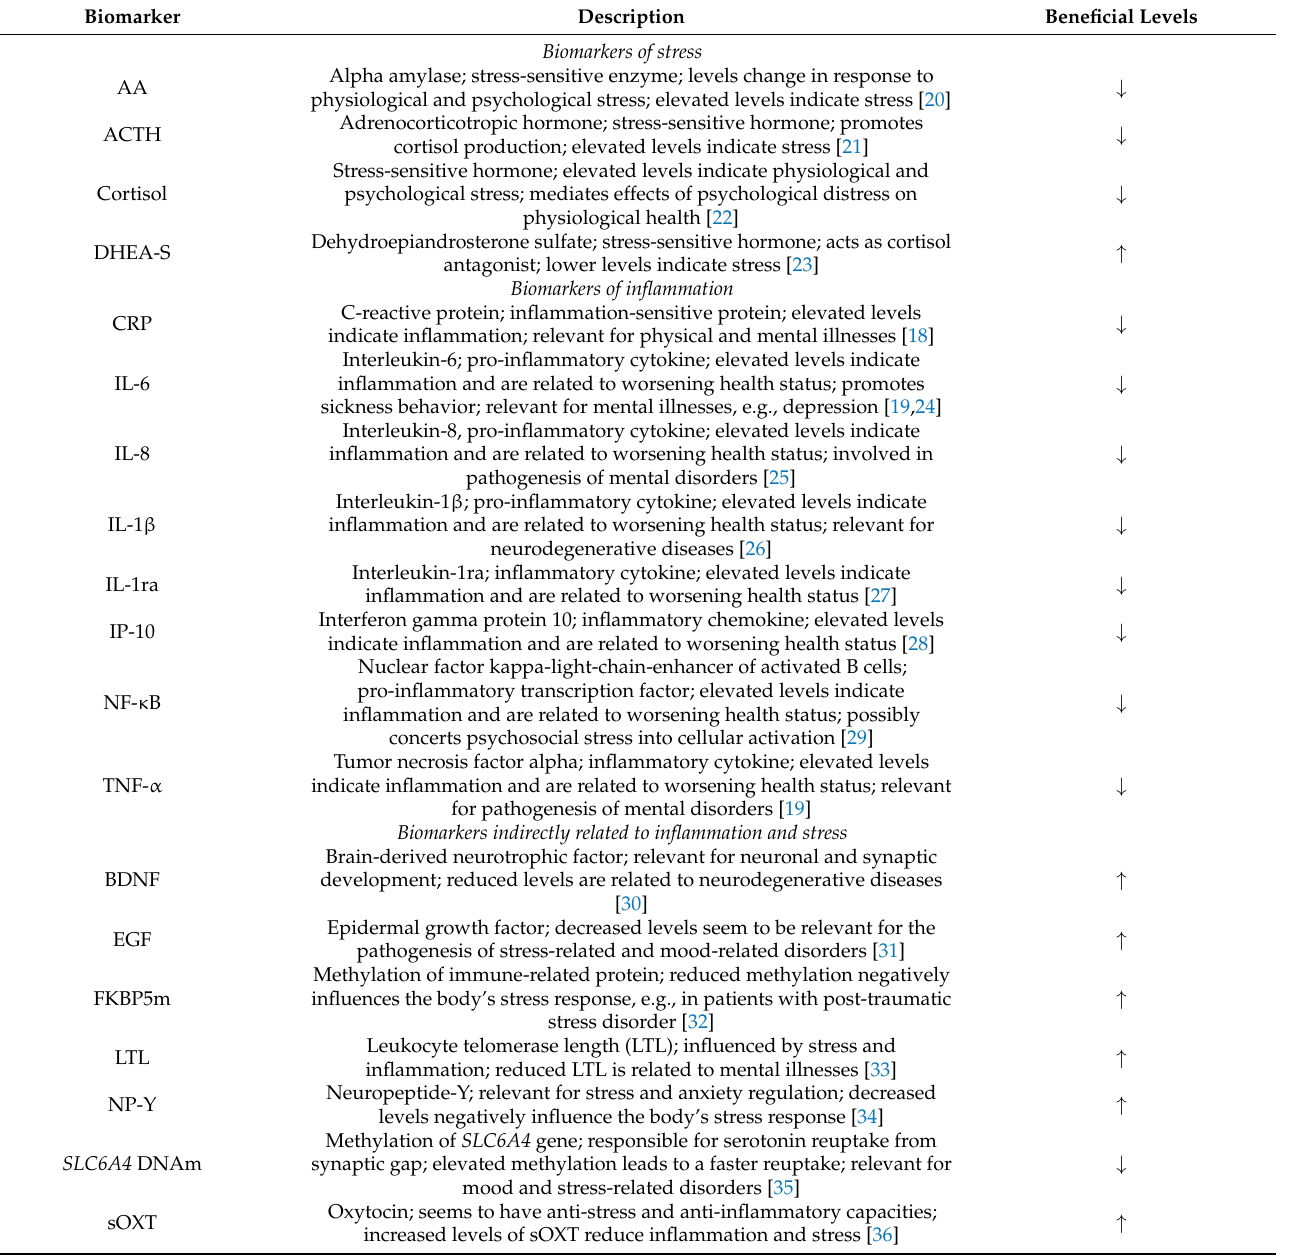
Table 1. Biomarkers of Inflammation and Stress Accounted for in the Meta-Analyses.